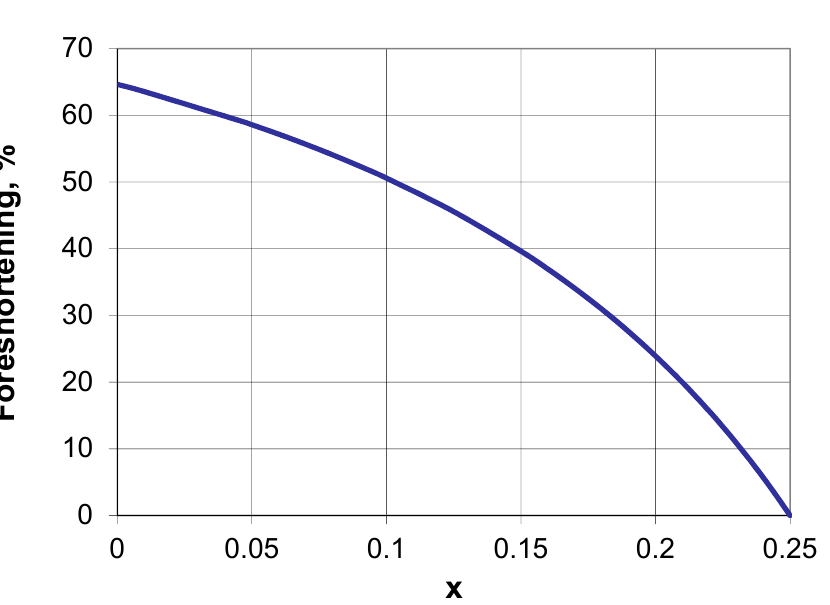
Figure 8. Shrinkage of the tubular structure, after the transition from open to the closed position, as a function of parameter x.